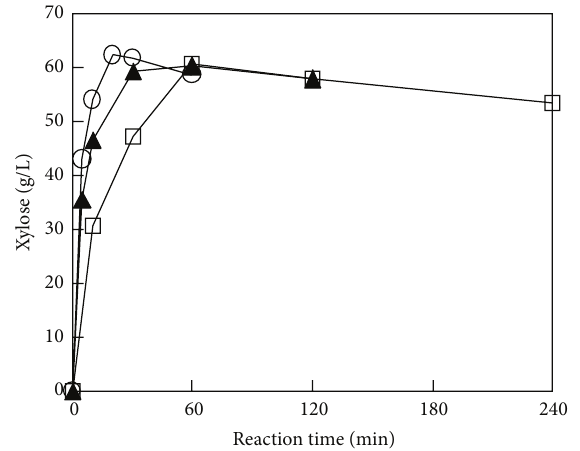
Figure 1: Time courses of xylose concentration at different tem- peratures. ◻ : 120 ∘ C; 󳵳 : 130 ∘ C; I : 140 ∘ C. Other conditions: 2% (w/v) H 2 SO 4 and 0.8% (w/v) H 3 PO 4 , liquid to solid ratio 3mL/g.